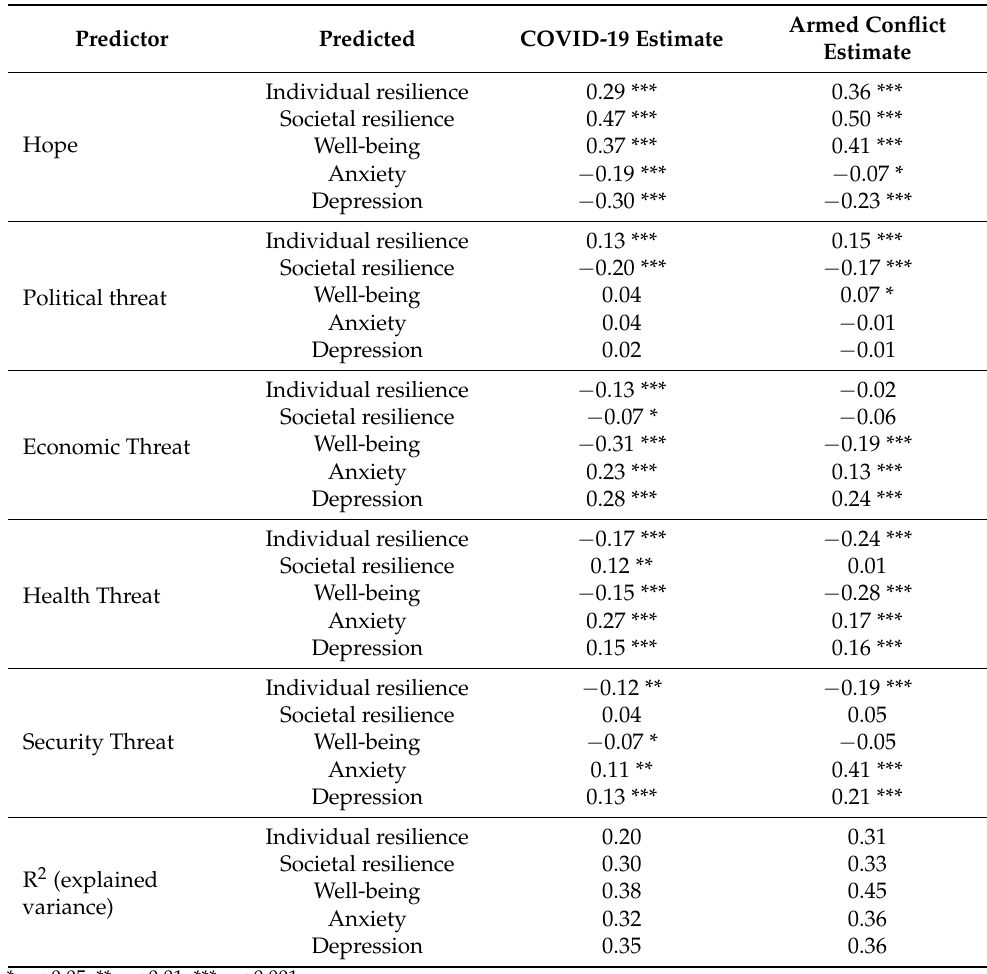
Table 2. Standardized estimated of path analyses of four type of threats and hope predicting indi- vidual and societal resilience, well-being, anxiety and depressive symptoms during the COVID-19 pandemic ( n = 699) and armed conflict ( n =